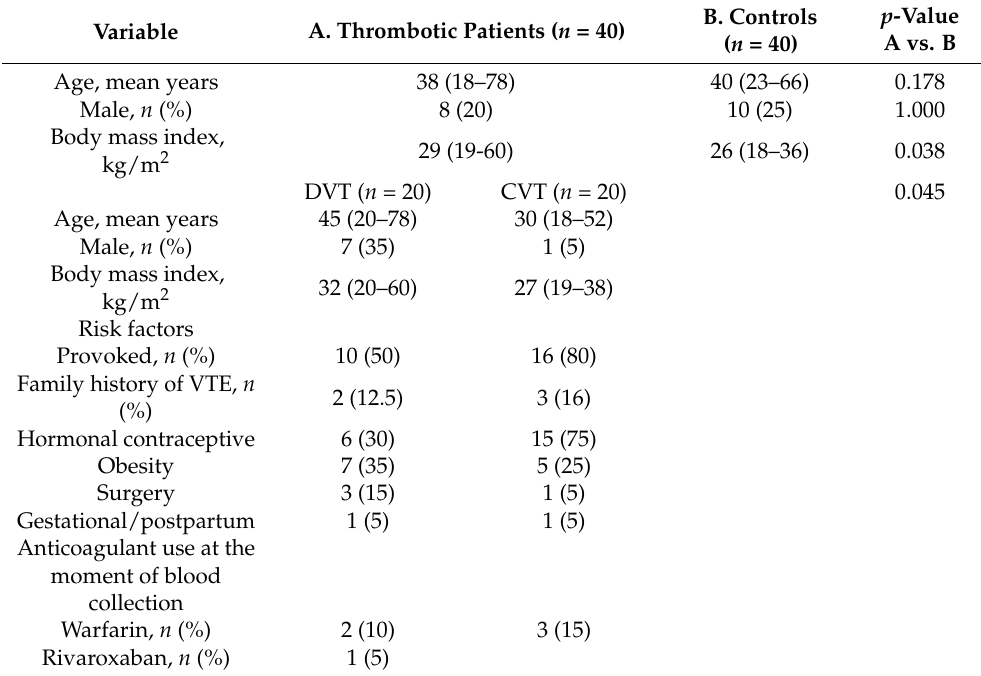
Table 1; Table 2 display the demographic and clinical variables of 32 women and 8 men, fulfilling the inclusion criteria. The median time between the thrombotic episode and blood collection was 13 months, and six patients were under anticoagulation with warfarin ( n = 5) or rivaroxaban ( n = 1) at the moment of blood collection. For the time between blood collection and the thrombotic episode, see Appendix A Tables A1 and A2. Analysis by age and sex between the thrombosis and control groups showed no significant differences. Table 1. Clinical summary of patients with different types of venous thrombosis. DVT: deep venous thrombosis in the lower limbs; CVT: cerebral veins thrombosis; BMI: body mass index. Variable